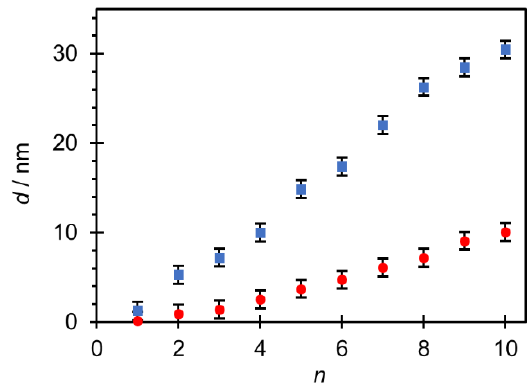
Figure 4. Thickness of PAH/PAA multilayers on Si ( ● ) and Ti ( ■ ) substrates determined by ellipsometry presented as a function of the number of deposited polyelectrolyte layers.